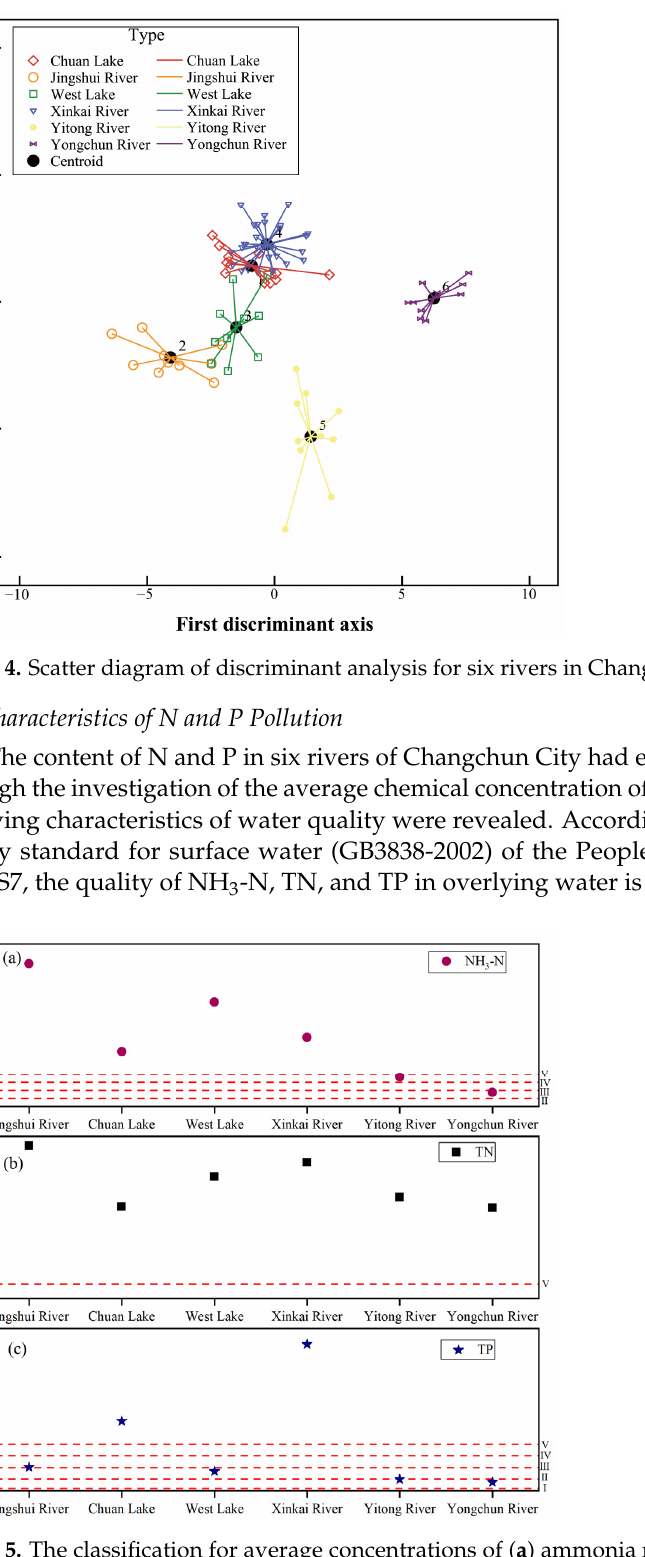
Figure 5. The classification for average concentrations of ( a ) ammonia nitrogen (NH 3 -N), ( b ) total nitrogen (TN), and ( c ) total phosphorus (TP) in the overlying water of six rivers in Changchun City (the red dashed lines represent the classification standard values of level I~V for surface water in Table S7).